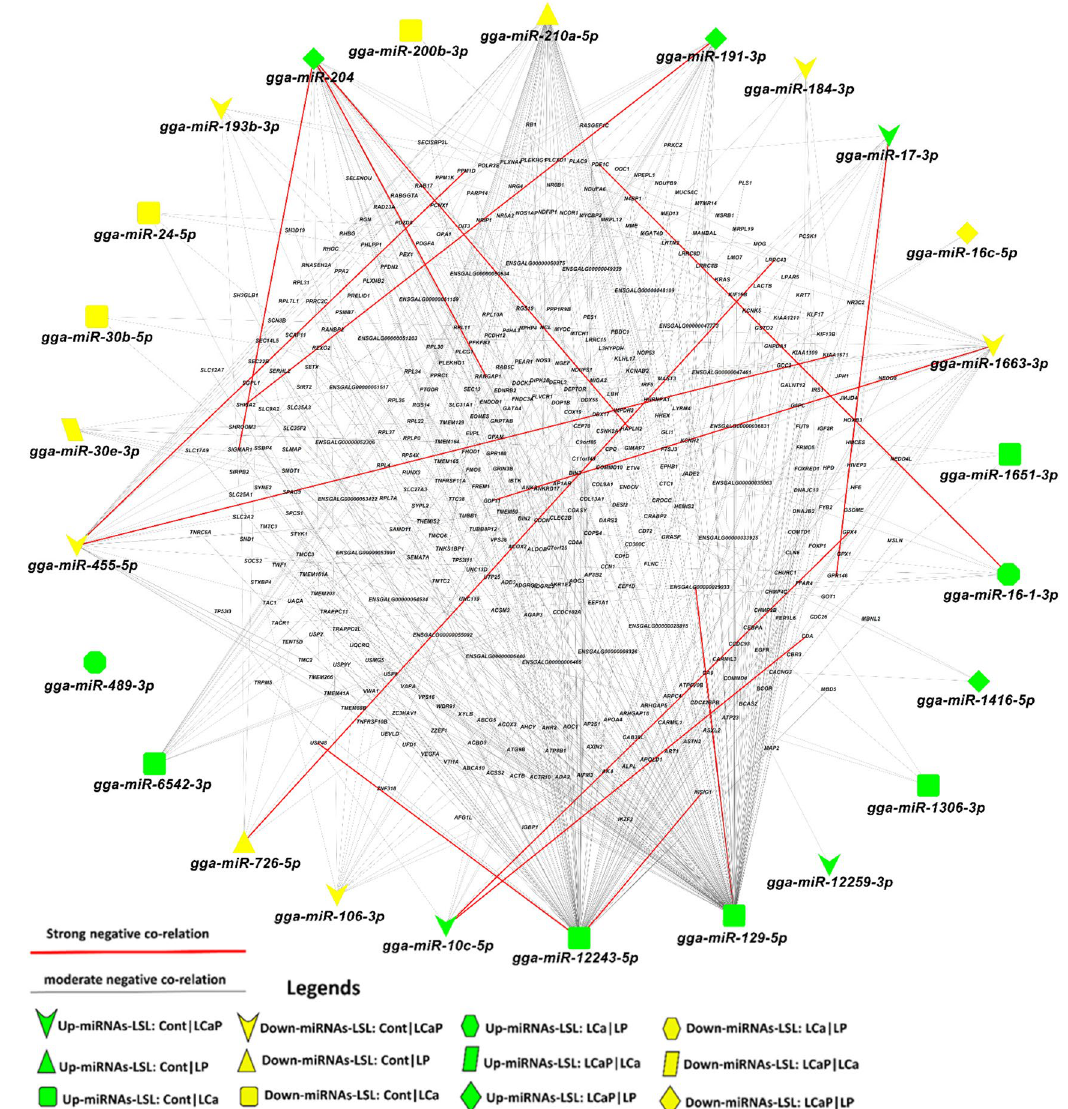
Figure 3. Correlation network analysis of differentially expressed (DE) known miRNAs and their DE target genes from pairwise comparisons between diet groups within LSL strain. Correlation network was generated using MetScape (version 3.1.3) plugin in Cytoscape (version 3.6.1) environment. The mRNAs with negative correlation with miRNAs were considered significant. Green color indicates upregulated miRNAs and yellow color indicates downregulated miRNAs. Red bold line indicates the strong negative correlation ranging from − 0.35 to − 0.60 and grey line indicates moderate negative correlation ranging from − 0.30 to − 0.35 according to their correlation coefficient